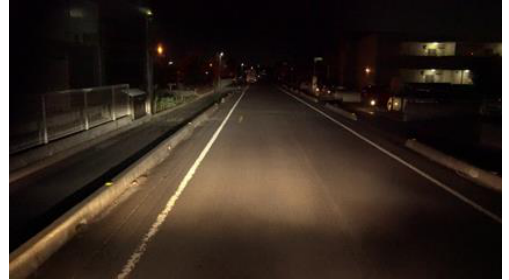
Figure 1 . High-sensitivity image.